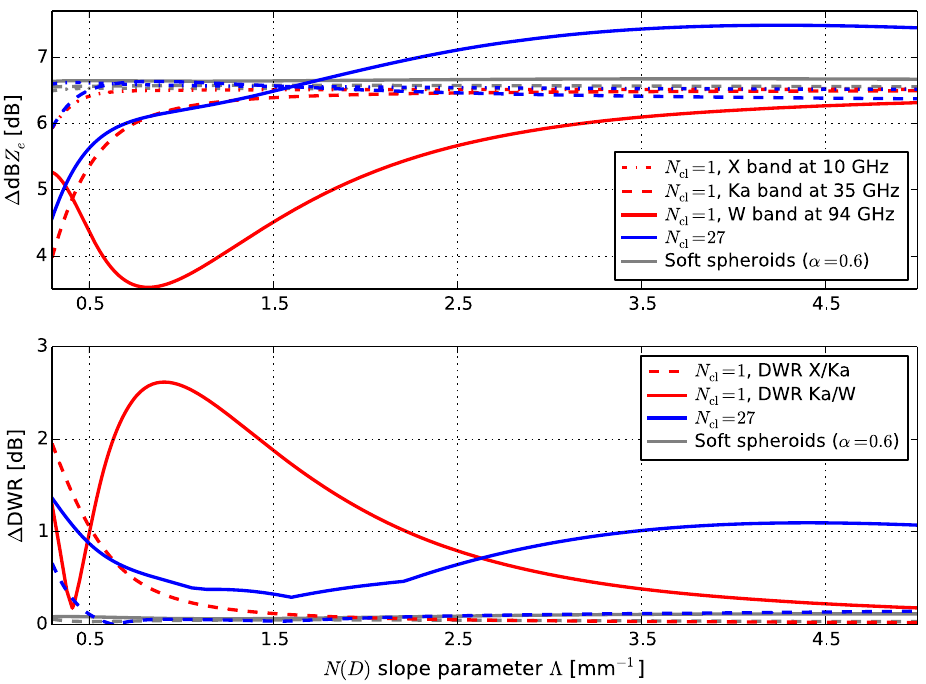
Figure 10. Impact of the parameterization of snowflake mass on modeled snowfall radar reflectivity factors Z e and dual-wavelength ra- tios (DWRs) for exponential size distributions N(D) with snowflake diameters of D ≤ 23 . 6mm and exponential slope parameters of 0 . 3 ≤ (cid:51) ≤ 5 . 0mm − 1 . Shown (cid:49) dB Z e and (cid:49) DWR curves indicate the maximum difference in derived dB Z e values and DWRs that is associated with uniformly increasing and decreasing all snowflake densities ρ f (D) obtained from the H04 density–diameter relationship, and thus all snowflake masses m f (D) determined from Eqs. (3) and (4), by 25% and by 50%. Modeling results for dB Z e at 14GHz and for DWR Ku/Ka are similar to shown dB Z e at 10GHz and DWR X/Ka, respectively. Collections of N cl = 125 ice spheres, corresponding to a normalized surface-area-to-volume ratio of ξ = 5, lead to similar (cid:49) dB Z e and (cid:49) DWR as the included ice sphere collections with N cl = 27 or ξ =